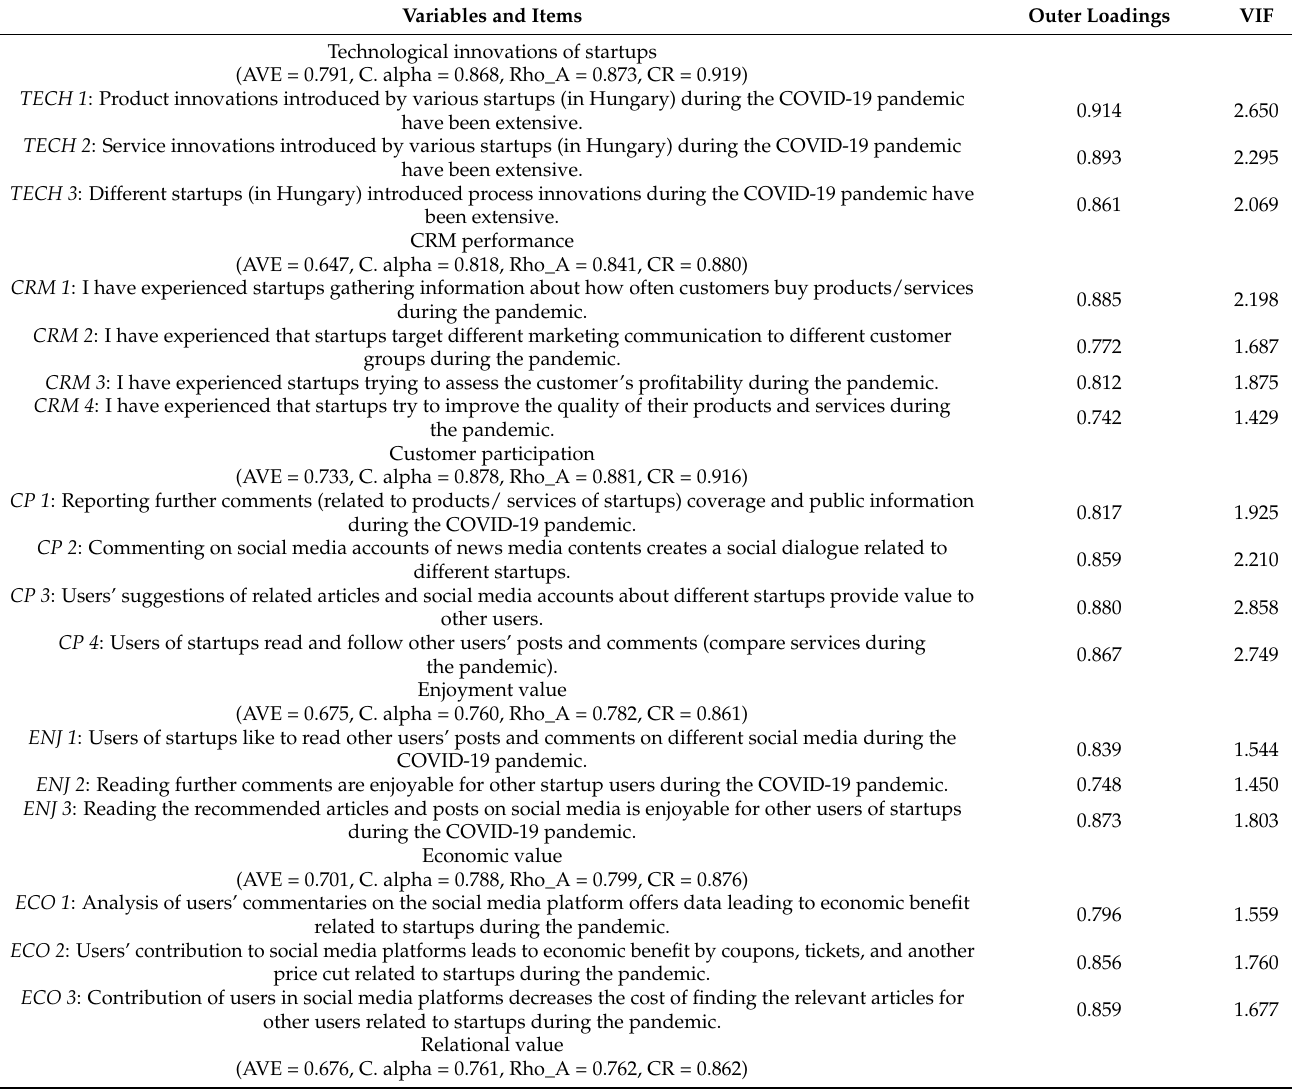
Table 2. Measurement